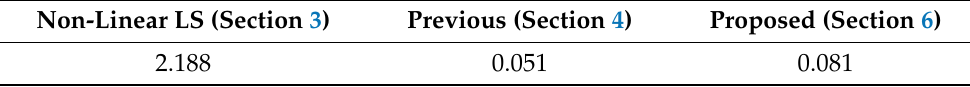
Table 4. Comparison of computational